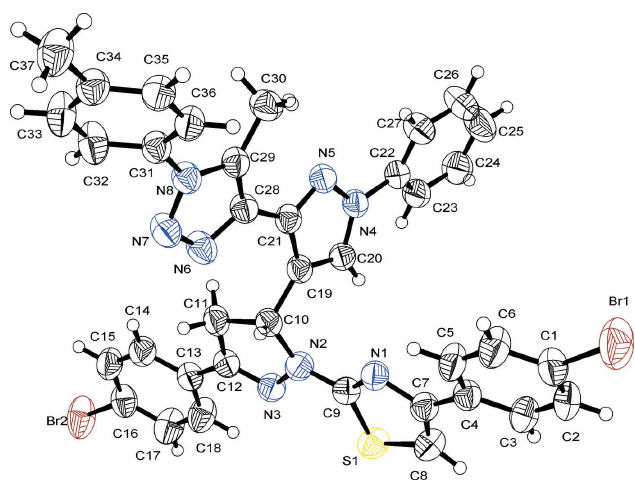
Figure 1 The title compound showing 50% displacement